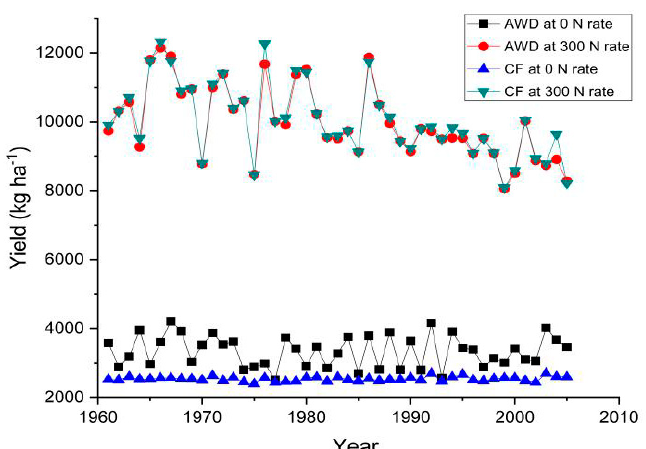
Figure 5. Simulated yields between 1961 and 2005, with AWD and CF conditions with 0 and 300 fertilizer N rates.